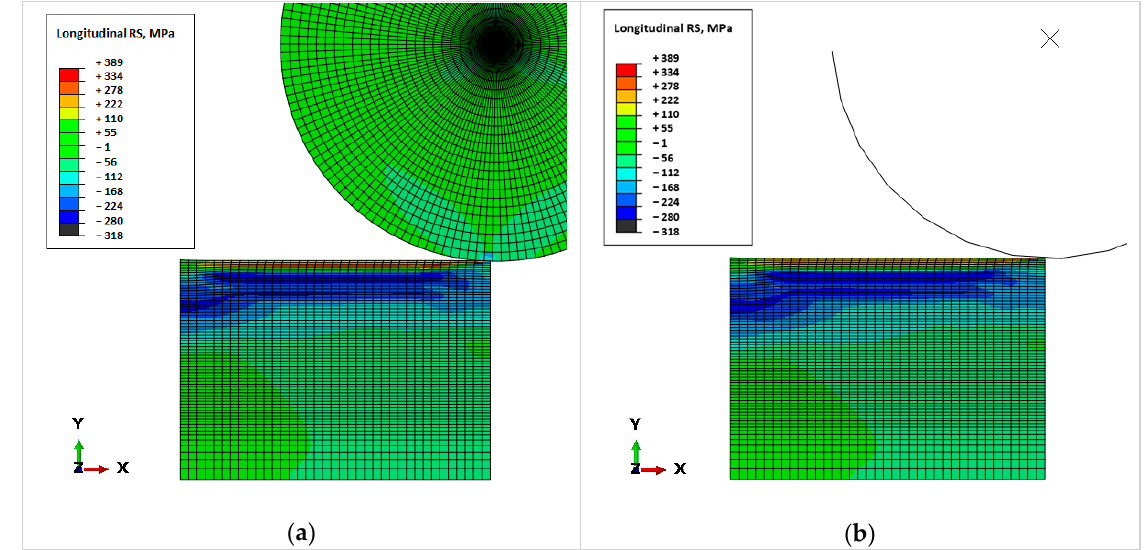
Figure 15. Longitudinal RS predicted by 2D short implicit transient models with elastic roller ( a ) and analytic rigid roller ( b ).